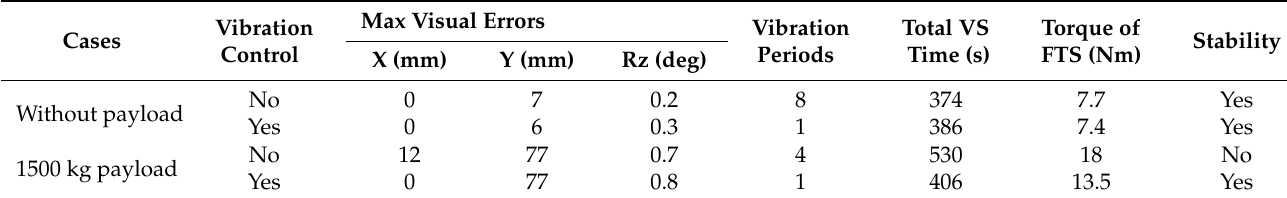
Table 4. Visual servo results of the two